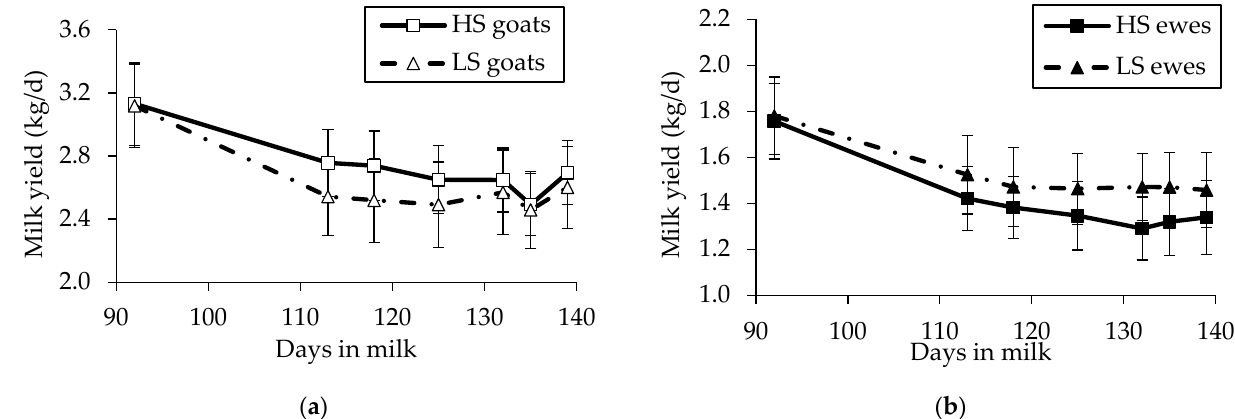
Figure 2. Evolution of milk yield (kg/d) in mid-lactating Saanen goats ( a ) and Sarda ewes ( b ) fed high-starch (HS) and low-starch (LS) diets. The vertical lines at each symbol indicate the SEM of the values. Table 3. Evolution of milk yield, fat-corrected milk yield, net energy of lactation, fat, protein, lactose, somatic cell count and urea in mid-lactating Saanen goats fed high-starch and low-starch diets. Last Day of the